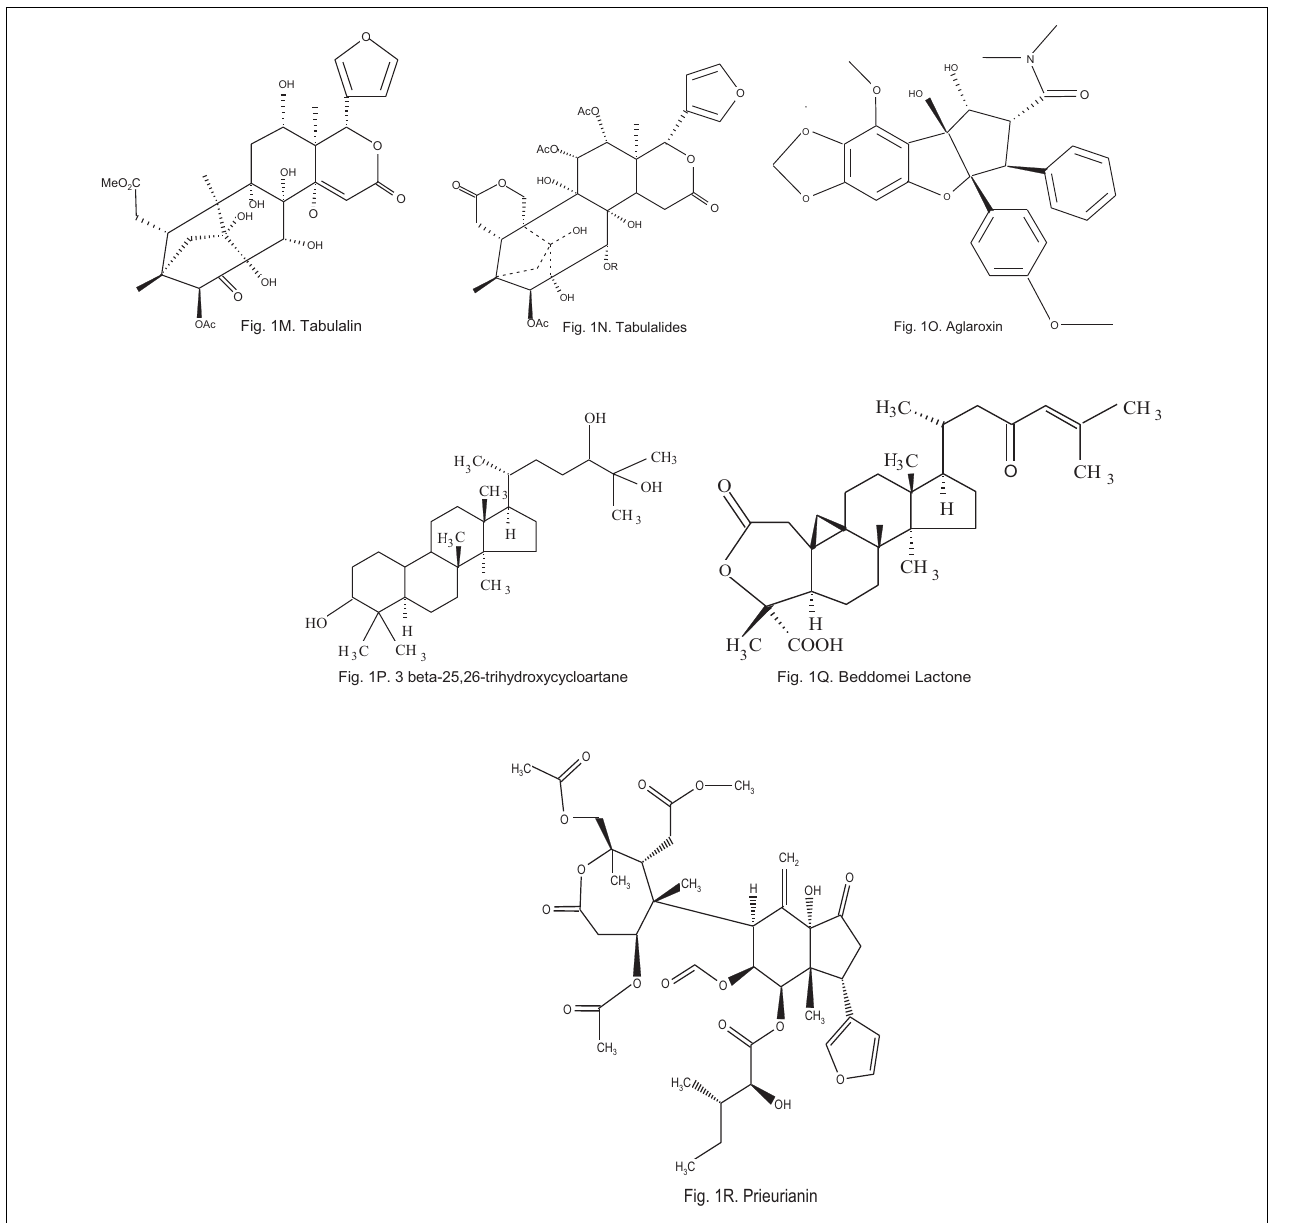
Fig. 1R. Prieurianin